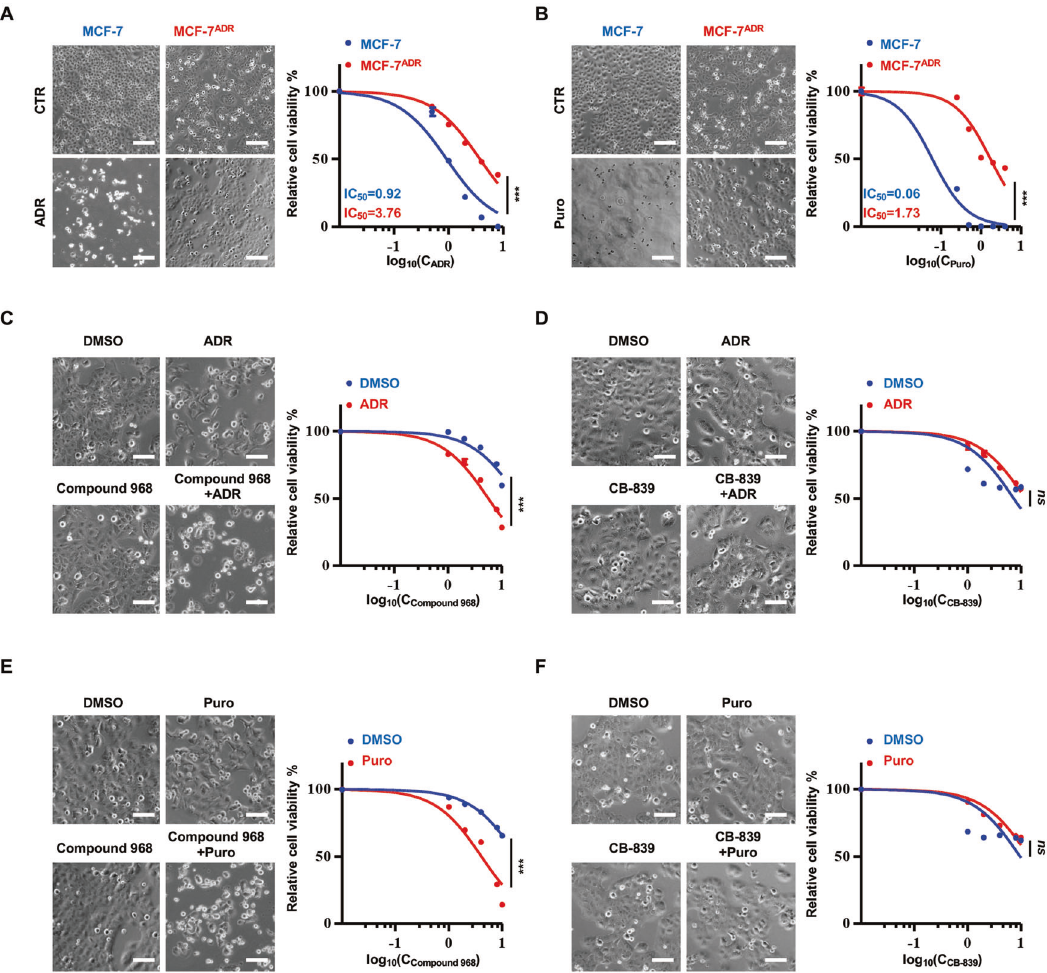
Fig. 1 Combining compound 968 with adriamycin (ADR) or puromycin (Puro) results in decreased viability of MCF-7 ADR cells. A , B MCF-7 and MCF-7 ADR cells were treated with ADR or Puro as indicated for 48 h. Cell viability was assessed using the CCK8 assays, and the IC 50 was calculated using GraphPad 7.0. Scale bars: 100 µm. C – F MCF-7 ADR cells were treated with compound 968 or CB-839 (0, 1, 2, 4, 8, and 16 µM) alone or in combination with 4 µM ADR ( C , D )/2 µg/mL Puro ( E , F ) for 48 h. All groups were normalized to the non-inhibitor-treated group. Cell viability was assessed using the CCK8 assays. Scale bars: 50 µm. Data are presented as mean ± SD (three independent experiments). ns no signi fi cance; *** P < 0.001, one-way